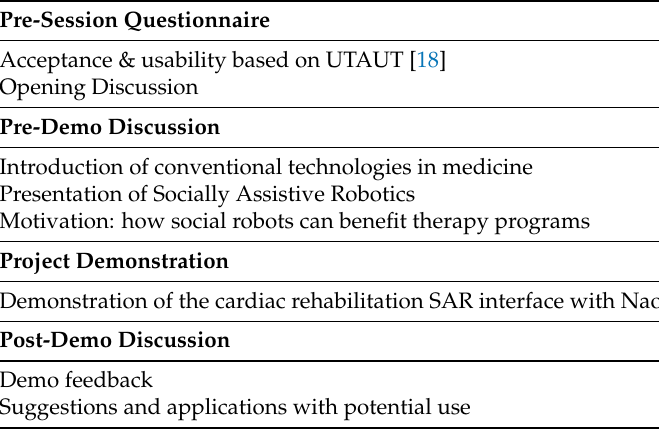
Table 4. Focus group with clinicians.